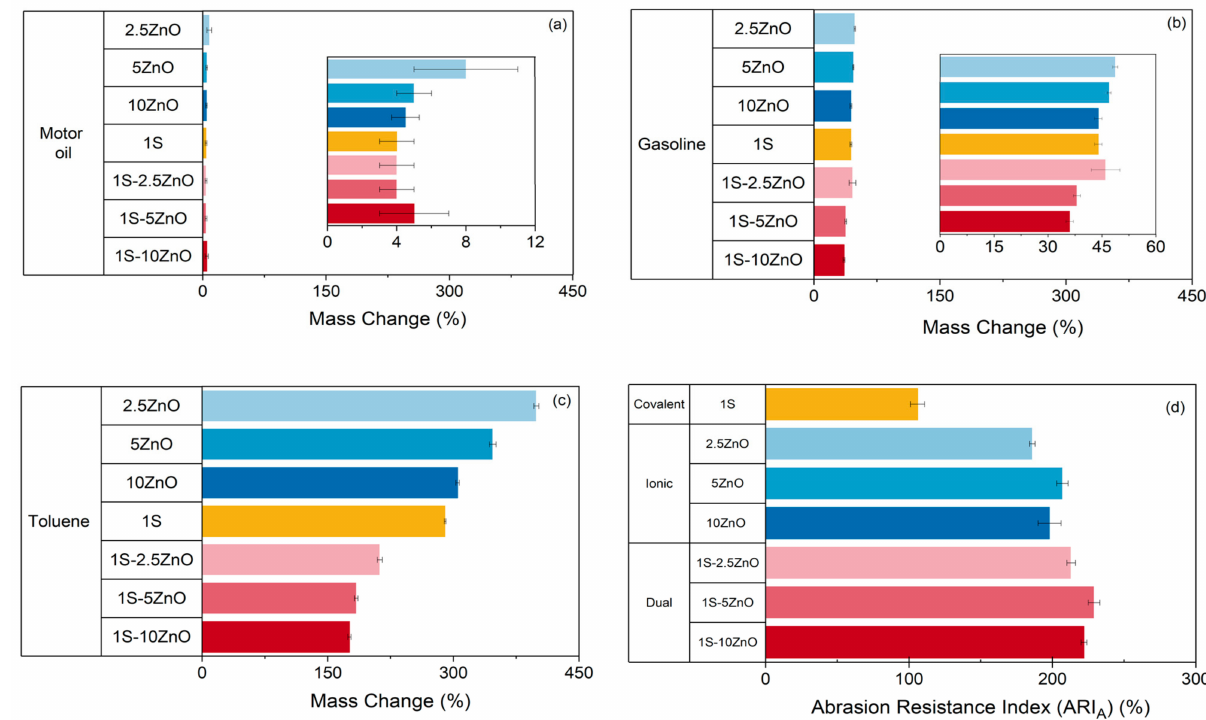
Figure 6. Chemical resistance in ( a ) motor oil, ( b ) gasoline, ( c ) toluene, and ( d ) abrasion resistance index (ARI A ) of covalent, ionic, and dual compounds